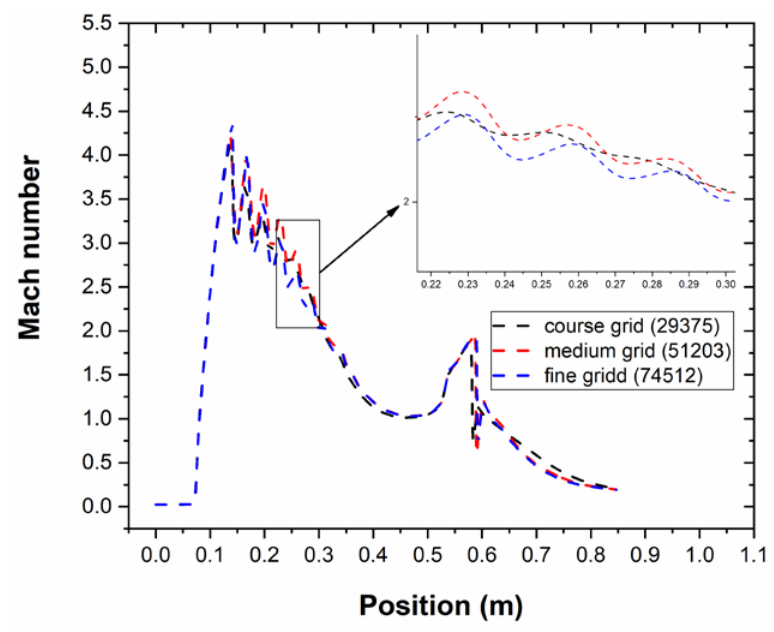
Figure 2. The Mach number with different grid density.